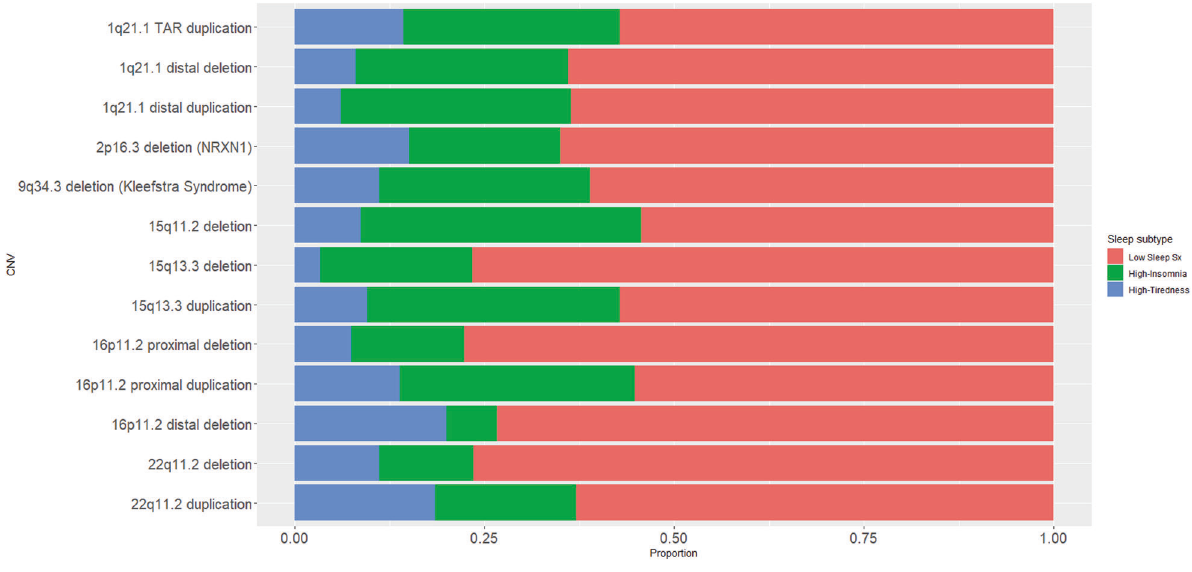
Table 2. Odds ratios for neuropsychiatric outcomes for children with an ND-GC with the Low Sleep Sx subgroup as the reference